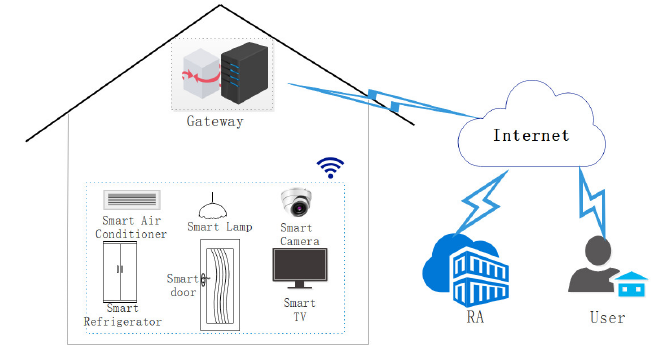
Figure 1. Traditional architecture of smart